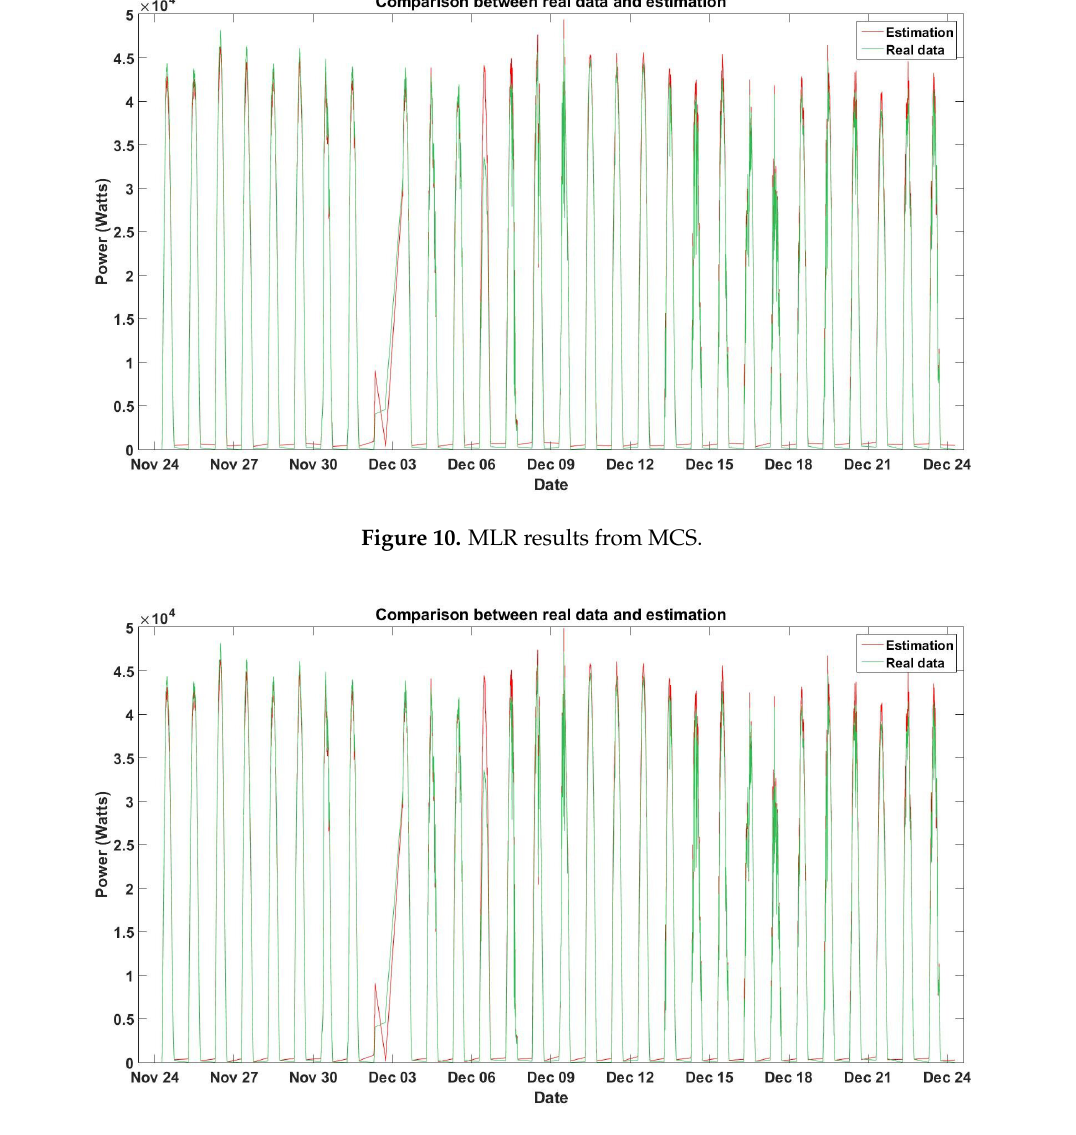
Figure 11. GDO results from